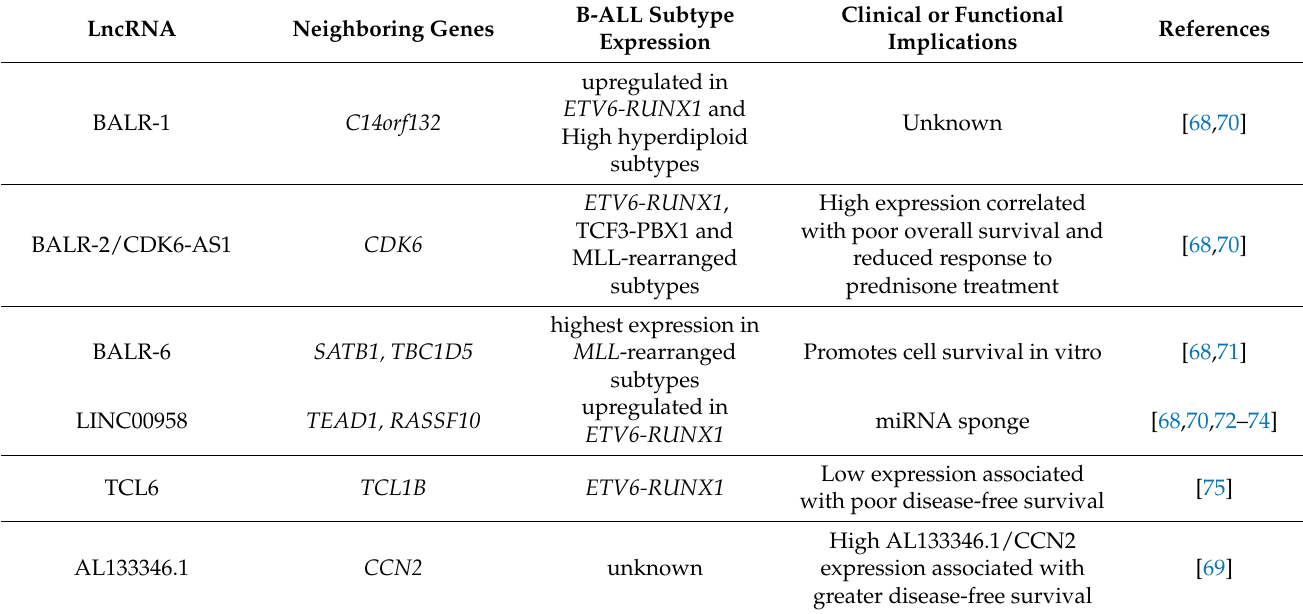
Table 1. Examples of lncRNAs with significance in B-cell acute lymphoblastic